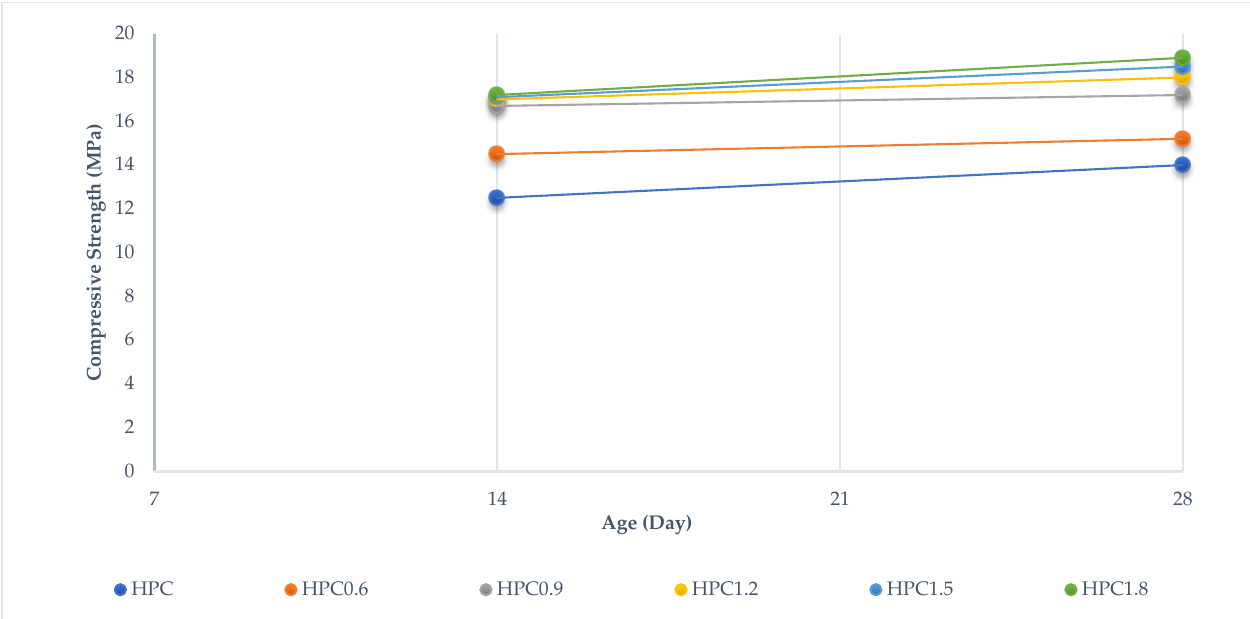
Figure 14. Flexural Strength of BFHPC with different BF Percentages.